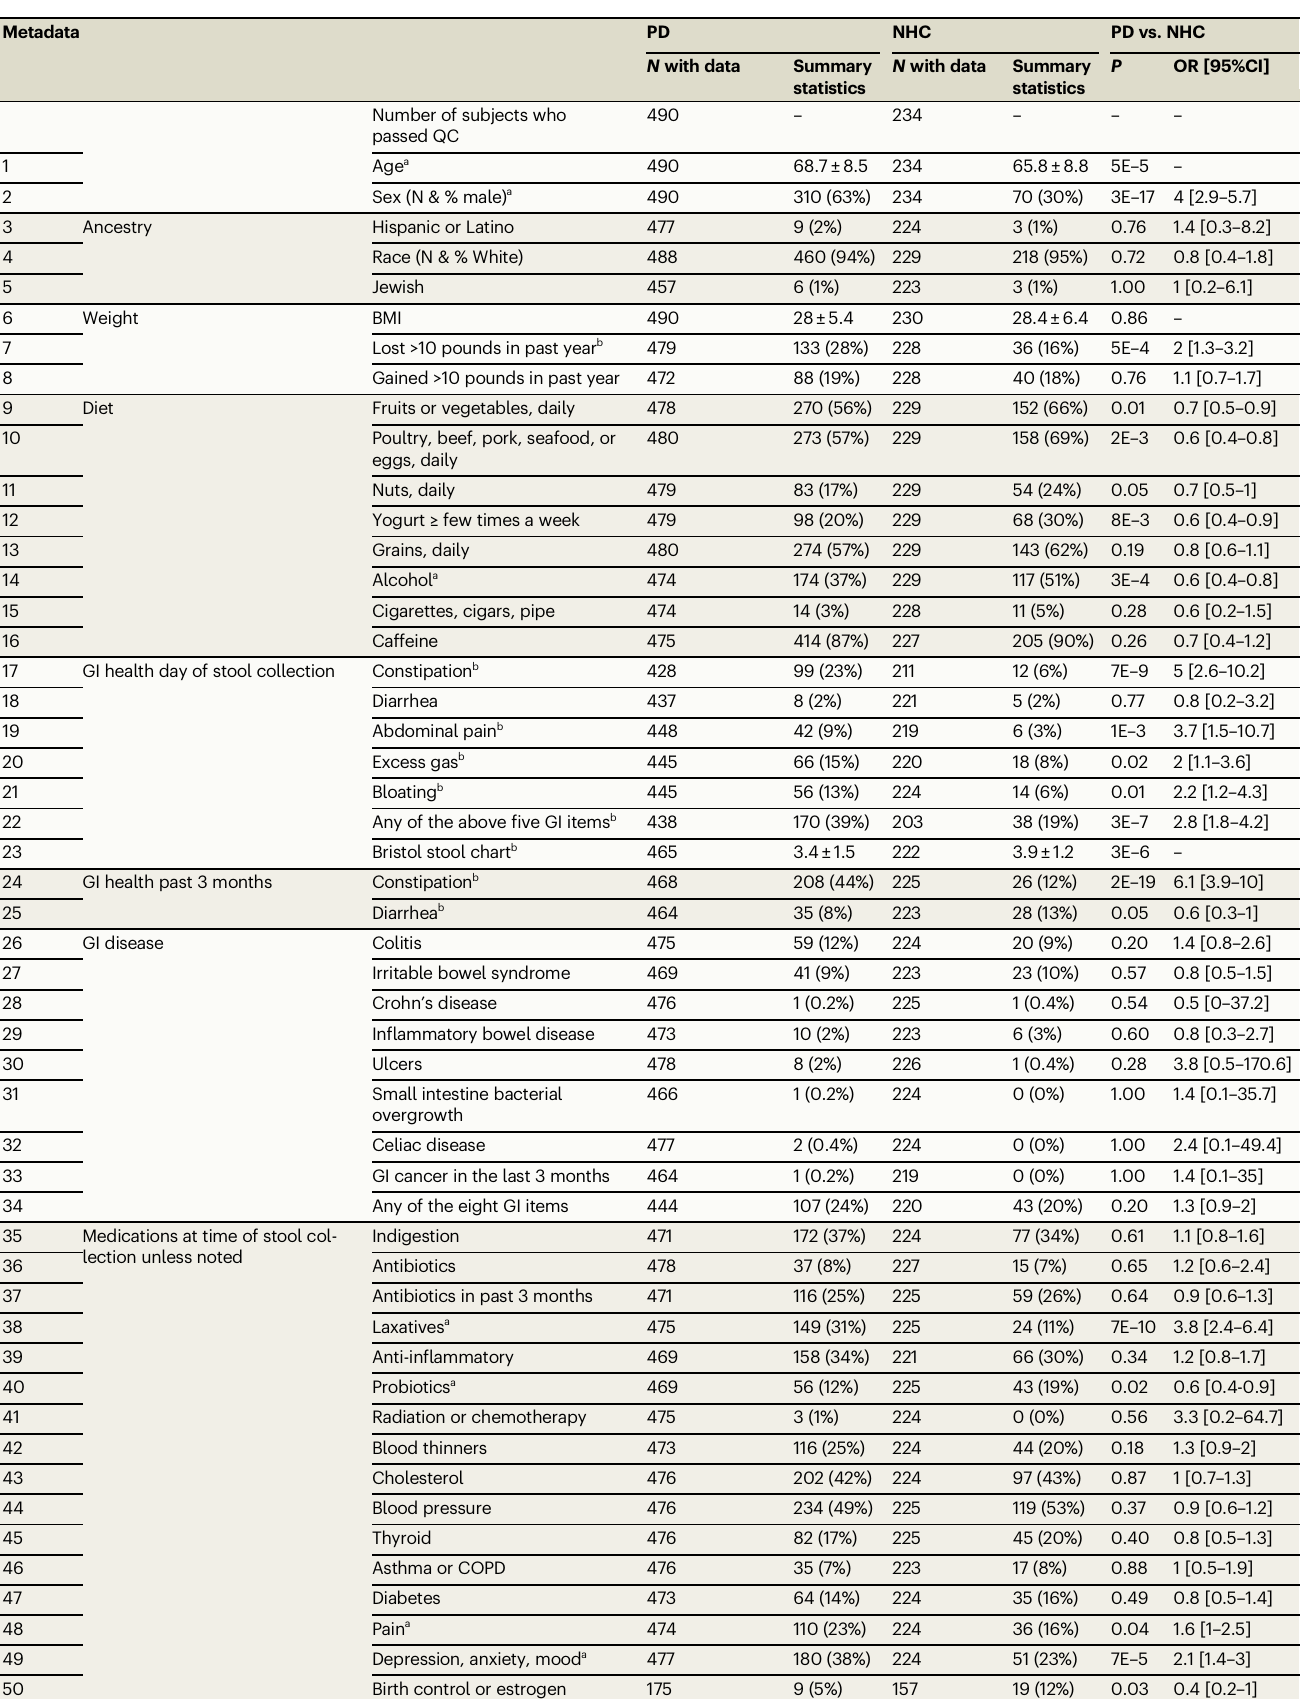
Table 1 | Subject characteristics and